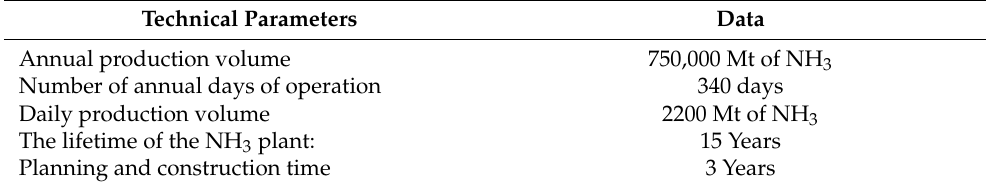
Table 1. Technical data block parameters.